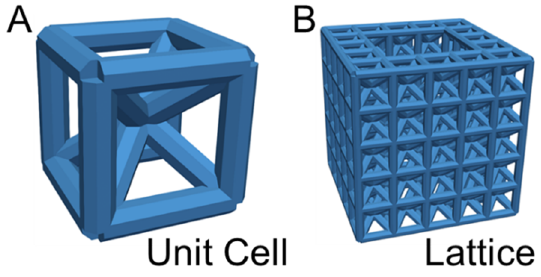
Figure 2. Example design for ( A ) a body-centered (BC) unit cell and ( B ) a BC-Void lattice built from BC unit cells.